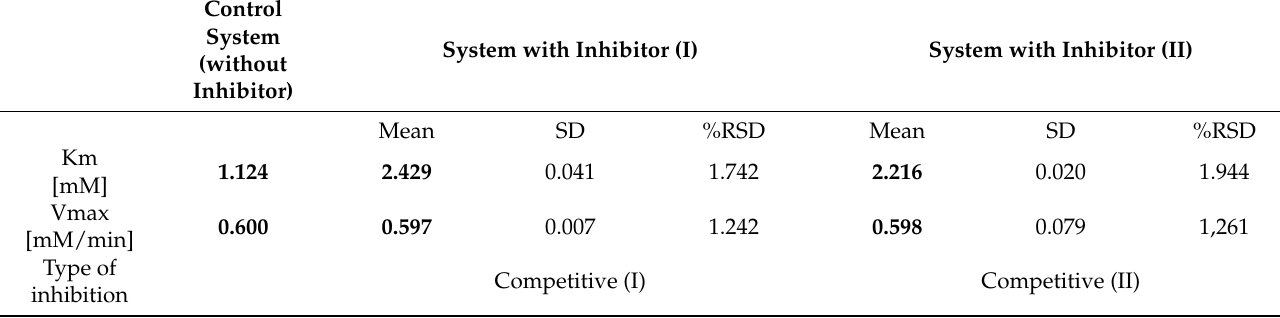
for which binding interaction was estimated as − 7.5 kcal/mol. Table 2. Determination of the inhibition type for PAP by comparing the Km and Vmax values between the control systems without inhibitor and the systems containing inhibitors (I) and (II) at a concentration of 0.05 mM. An increase of the Km value with a constant Vmax value in comparison to the basic system indicates the stronger competitive type of inhibition (compound (I)). A constant Km value with a reduced Vmax value in comparison to the basic system indicates the weaker competitive type of inhibition (compound (II)). The results show the mean values for the concentration of 0.05 mM inhibitors (I) and (II) for the 9 substrate concentrations. Each measurement was performed six times ( n = 6).